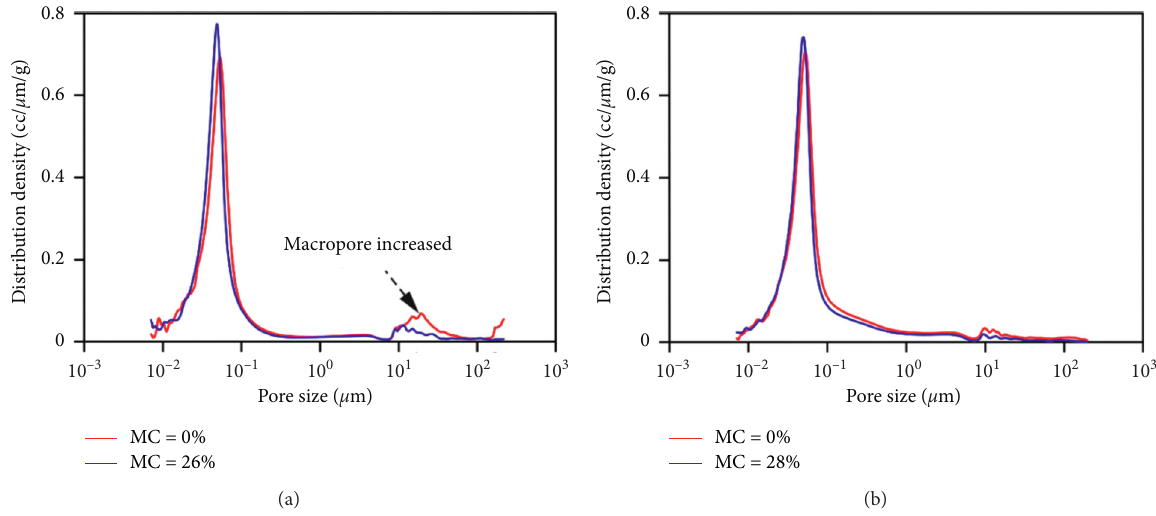
Figure 13: Pore size distributions of treated laterite. (a) LaL. (b)